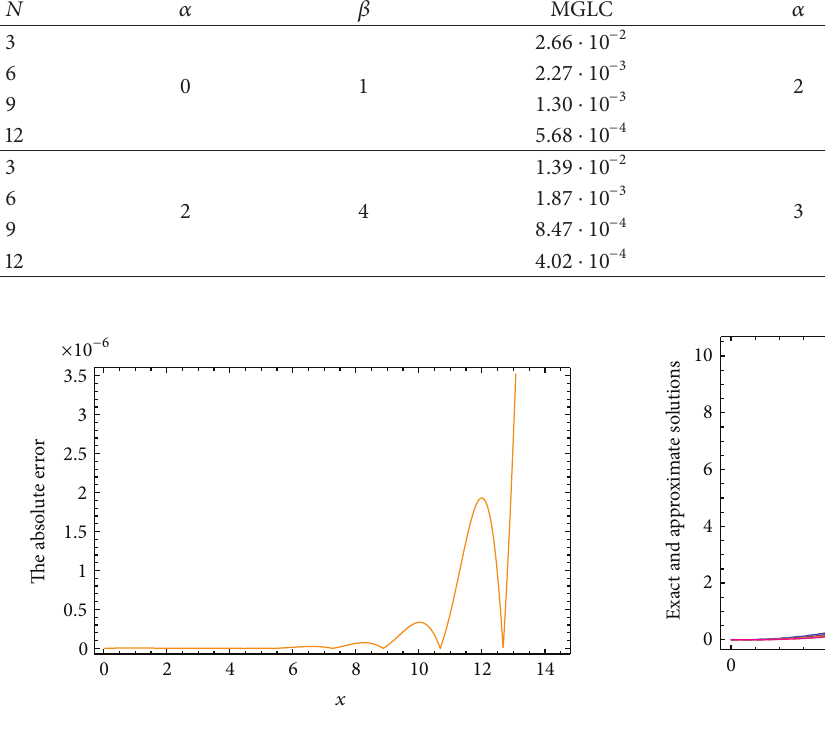
Figure 11: The absolute error for 𝛾 = 1/100 , ] = 3/4 , 𝛼 = 2 , and 𝛽 = 2 at 𝑁 = 20 .